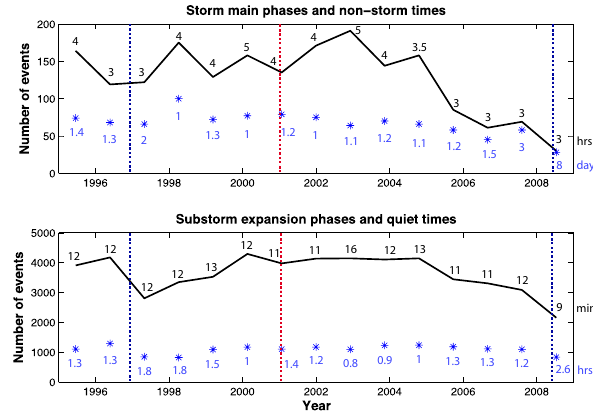
Fig. 3. Annual distribution of storm main phases and non-storm times (top) and substorm expansion phases and quiet times (bot- tom). The numbers of non-storm (top panel) and quiet times (bot- tom panel) are marked with blue asterisks. Annual median duration values are given for main phases (top panel) in hours and expansion phases (bottom panel) in minutes, both in black numbers. Corre- spondingly, annual median durations of quiet times (bottom panel) are annotated in minutes and non-storm times (top panel) in days, both in blue numbers. The vertical dotted lines mark the solar min- imum years (blue) and solar maximum year